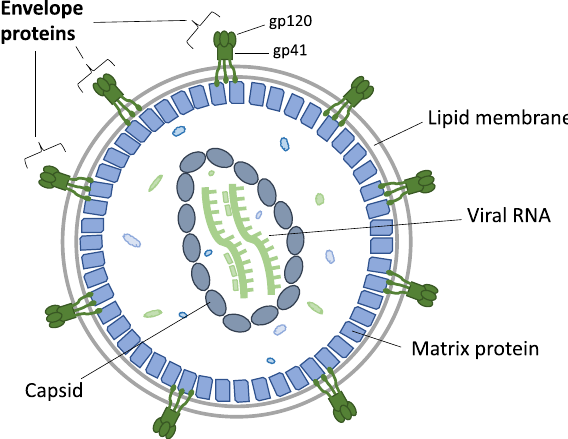
Figure 1: Illustration of the structure of HIV. The envelope protein, which includes the gp120 and gp40 sub - proteins, is the putative binding site for antibodies and other immune